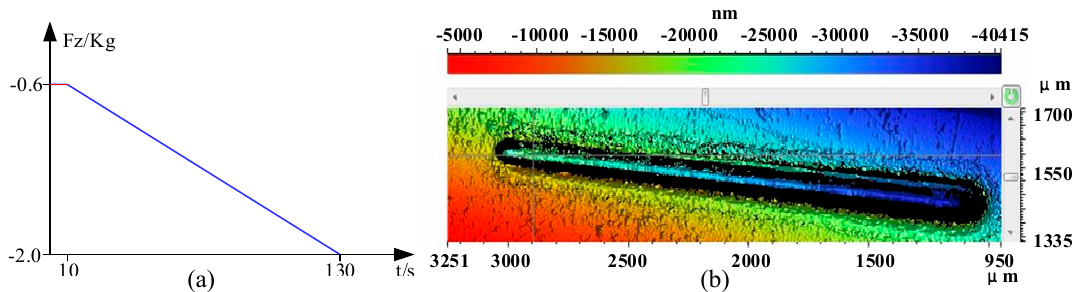
Figure 6. Process and result of scratch test: ( a ) Loading process of scratch test, ( b ) Scratch morphology.